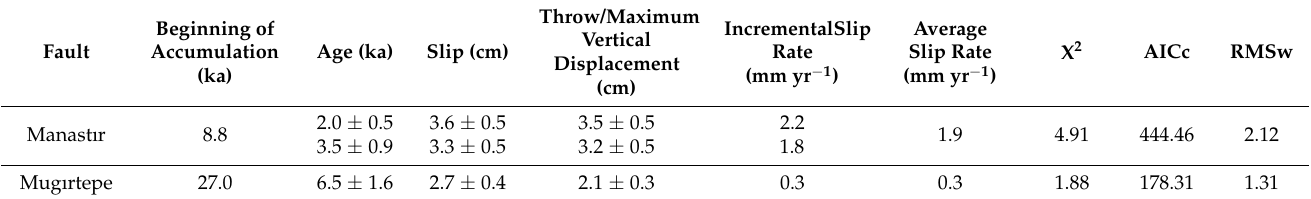
Table 5. Best fit results for the modeling of the Manastır and Mugırtepe fault scarps dataset. Beginning of Fault